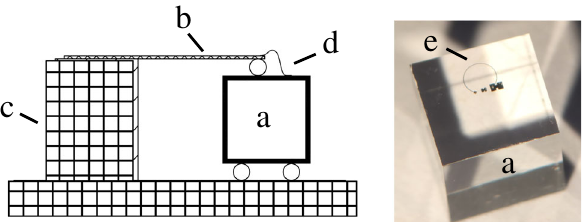
Fig. 1 Left: Schematic drawing of the detector crystal (a) and the cop- per holder (c). The crystal is placed on Al 2 O 3 balls and is pressed from top by a flexible bronze clamp (b). Bond wires (d) provide electrical and thermal connection. Right: Picture of the prototype Al 2 O 3 crystal (a) with the specially designed TES (e). For details see text